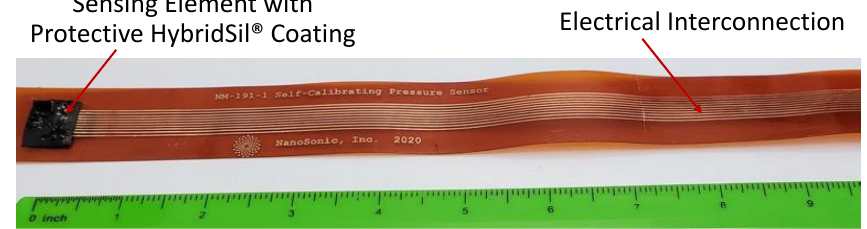
Figure 4. Photo of a prototype flexible two-phase, self-calibrating pressure sensor.